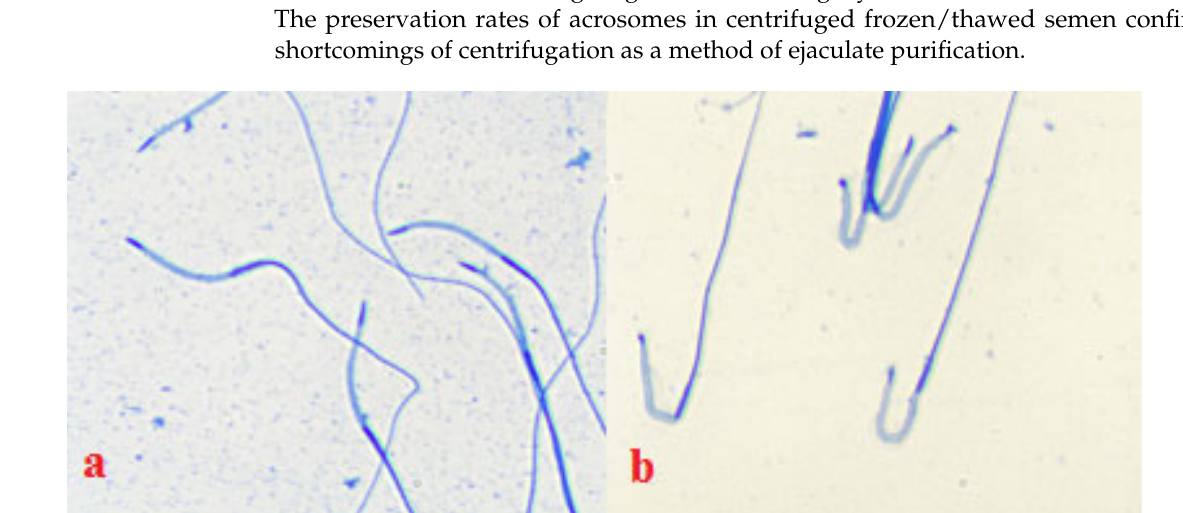
5537 Figure 2. Evaluation of viability of spermatozoa (eosin/nigrosin) under the influence of technologi ‐ cal factors: ( a ) native diluted semen (filtration); ( b ) frozen/thawed semen (filtration); ( c ) fro ‐ zen/thawed semen (centrifugation). Classification: pink ‐ stained spermatozoa were considered dam ‐ aged (dead), white cells were considered intact (alive).